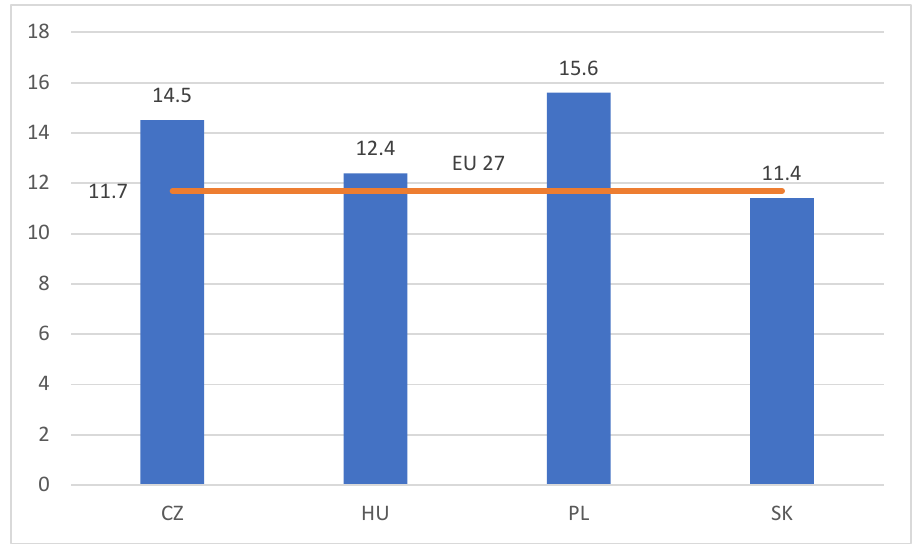
Figure 1. The average age of buses and coaches in operation in the V4 and EU countries in 2019. Source: own study based on ACEA [23].